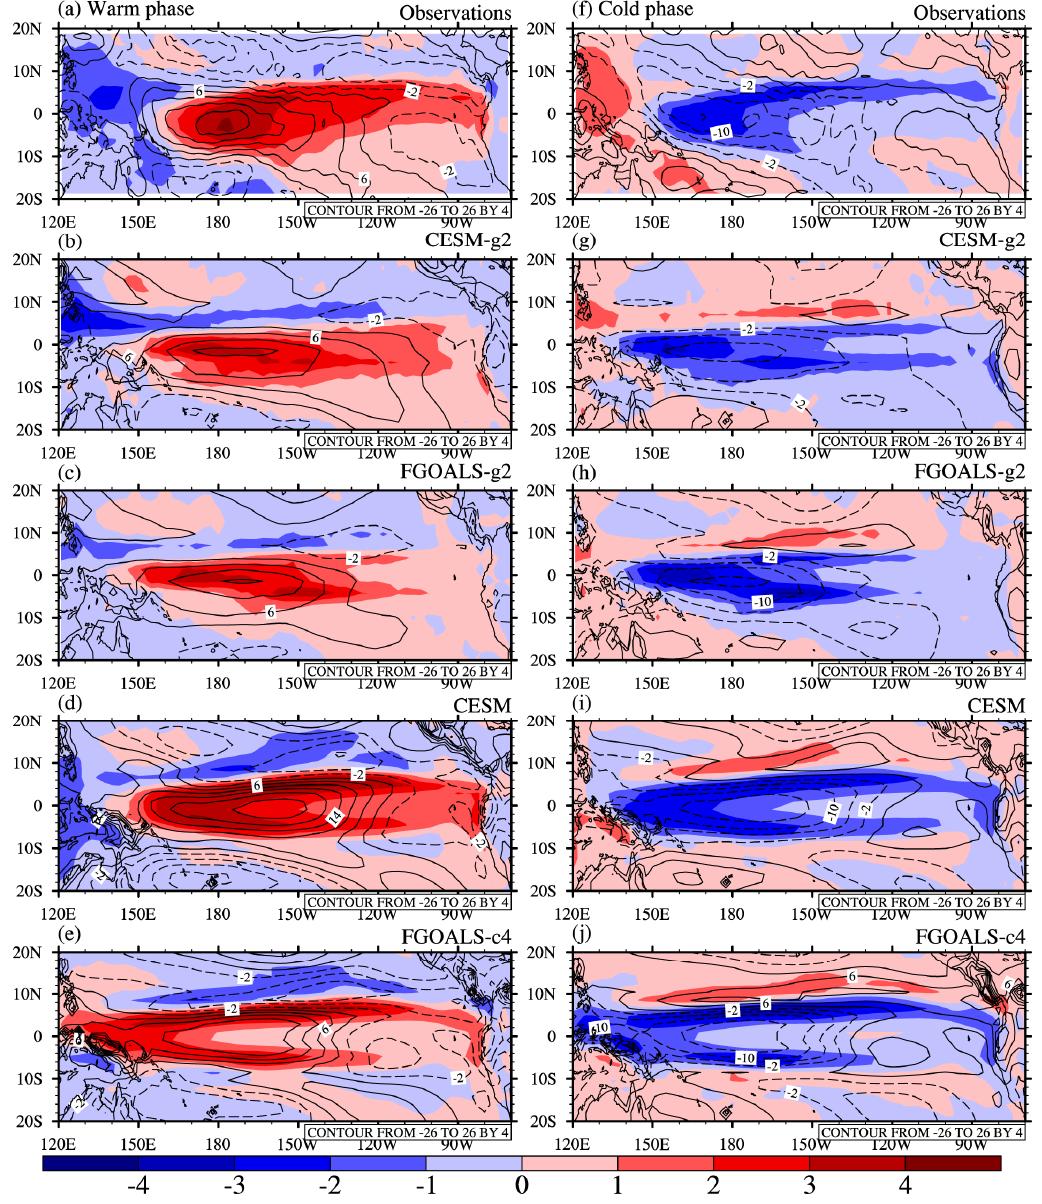
Figure 4. Spatial patterns of averaged composite anomalies of the warm phase (Left) and cold phase (Right) for precipitation (shaded; unit: mm / day) and zonal wind stress (contours; unit: 10 –3 N / m 2 ) from ( a , f ) the observations and the four cross-coupled parent models: ( b , g ) CESM-g2, ( c , h ) FGOALS-g2, ( d , i ) CESM, ( e , j ) FGOALS-c4. The validation data for precipitation are from the Global Precipitation Climatology Project (GPCP) (1979–2009) and for zonal wind stress from SODA 2.2.4 (1958–1999).